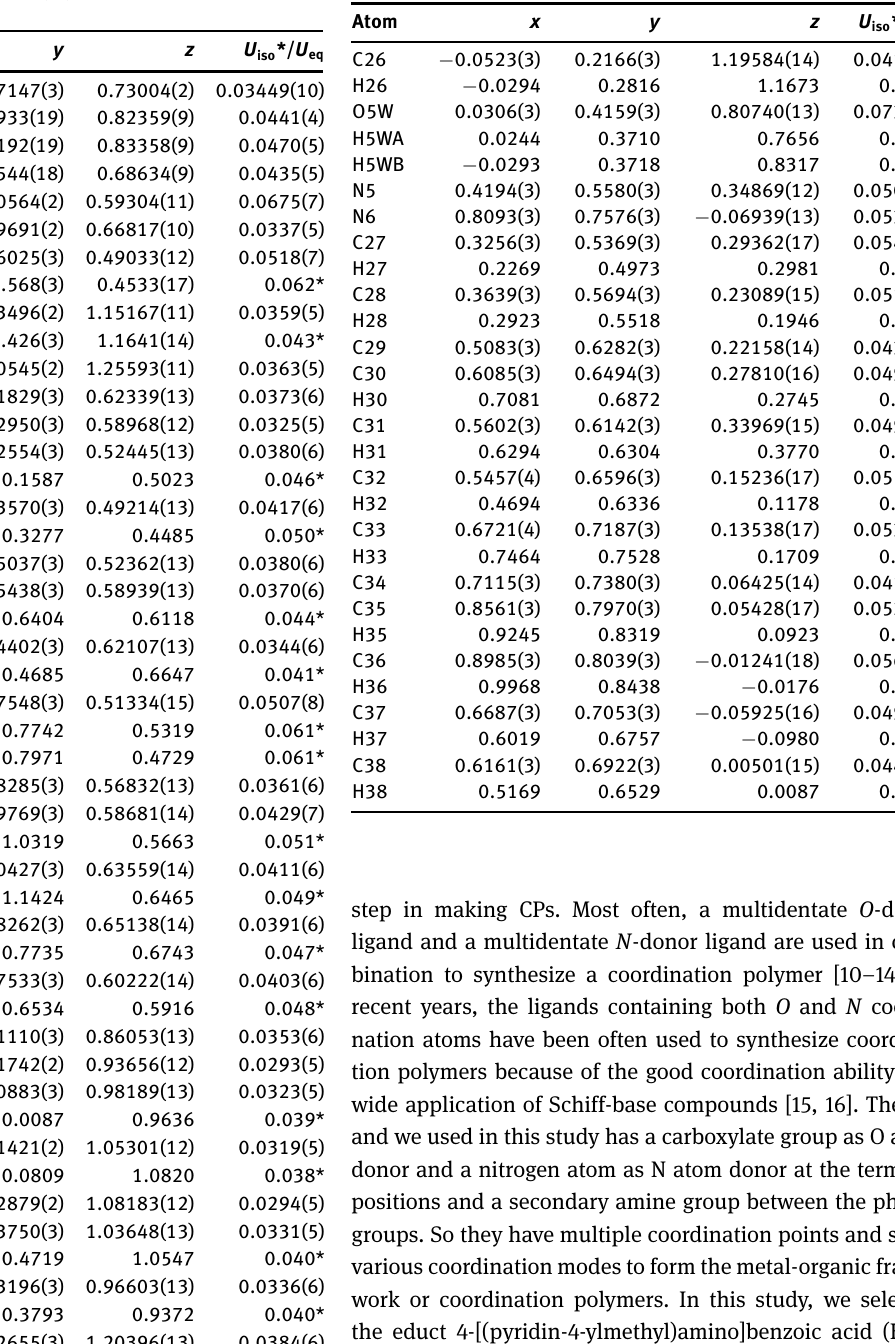
Table 2: Fractional atomic coordinates and isotropic or equivalent isotropic displacement parameters (Å 2